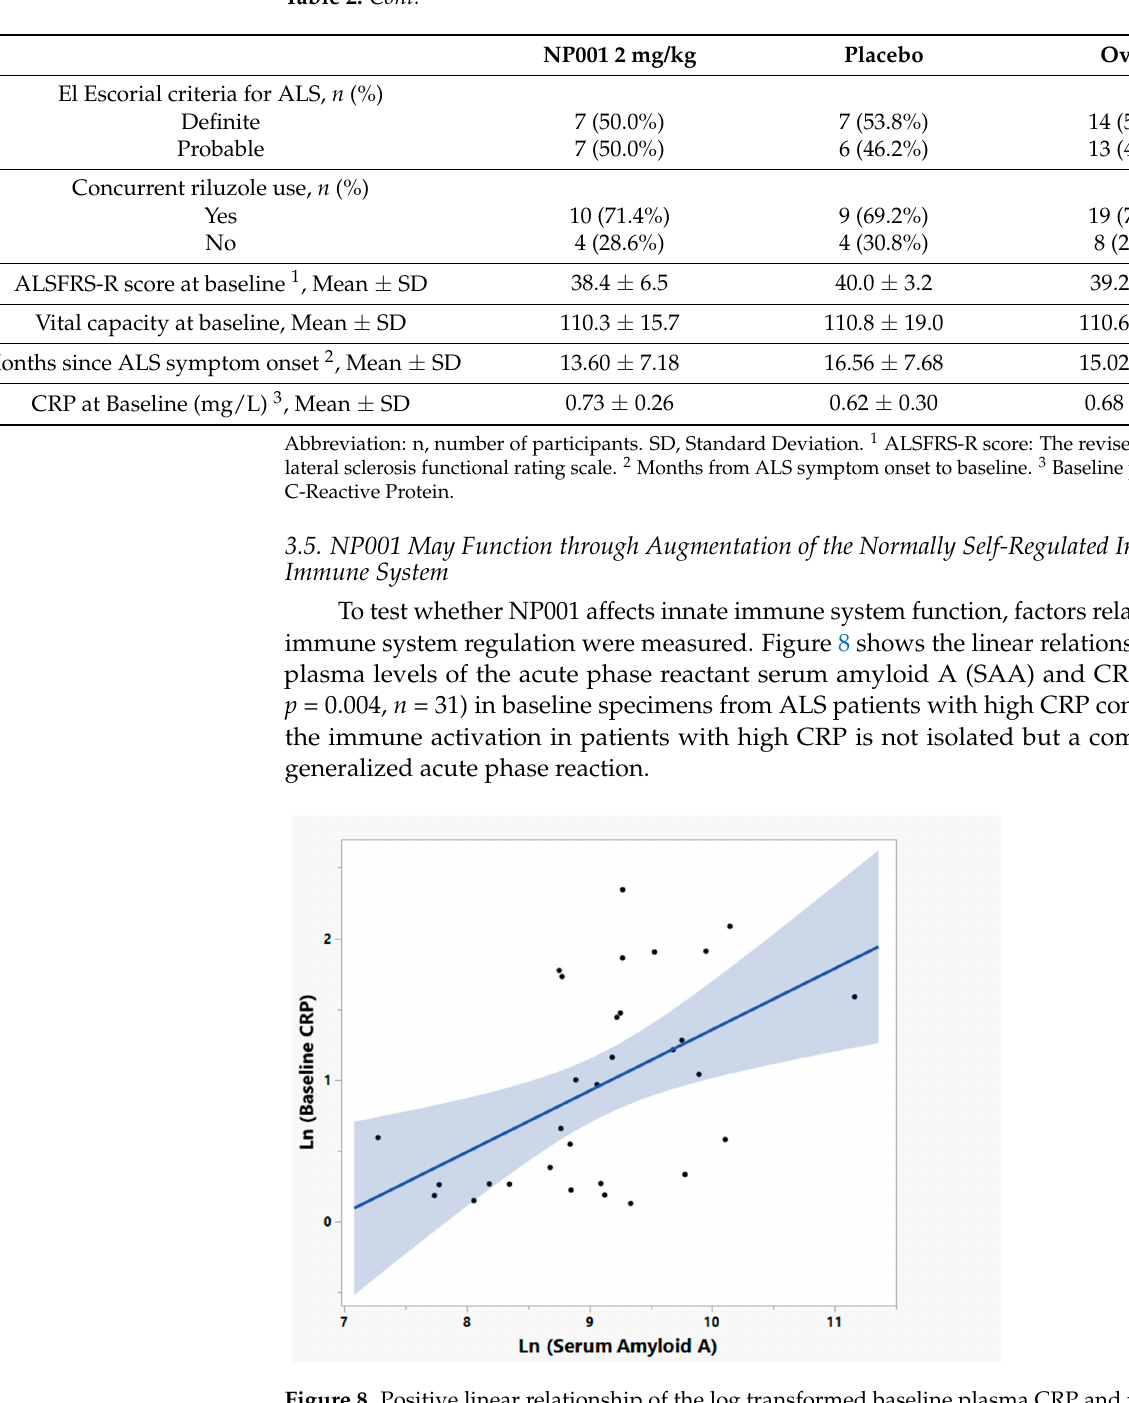
Figure 8. Positive linear relationship of the log transformed baseline plasma CRP and plasma Serum Amyloid A (SAA) in ALS patients age (cid:3409) 65 years old and high plasma CRP at baseline (Bivariate linear regression analysis, R 2 = 0.25, p = 0.004, n = 31).